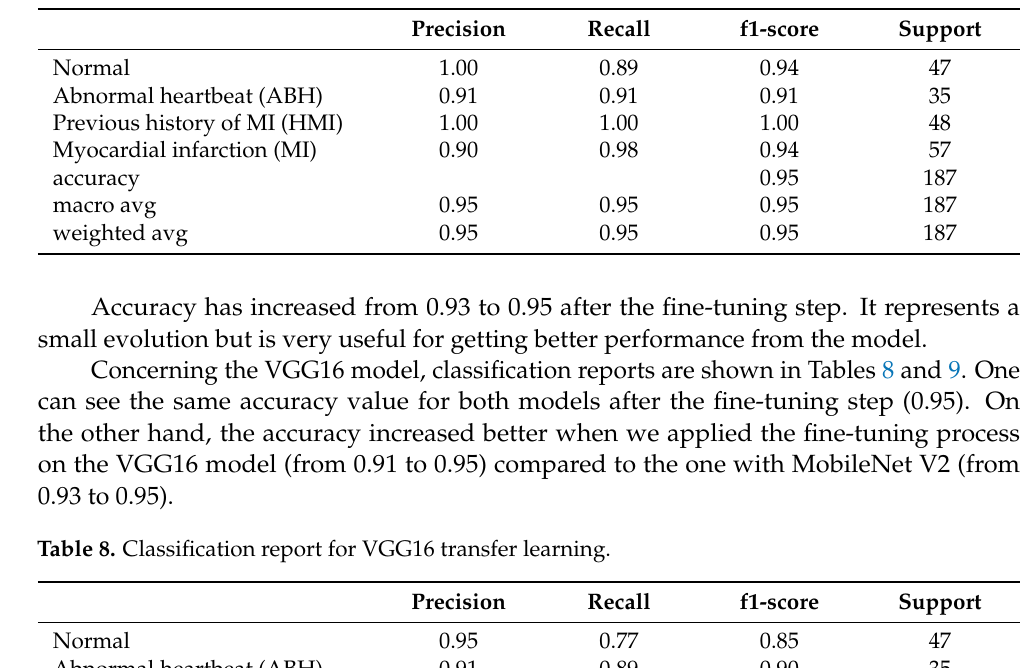
Table 7. Classification report for MobileNet V2 fine-tuning.